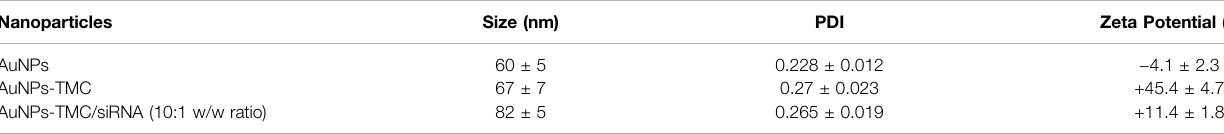
TABLE 2 | Size, PDI, and zeta potential of NPs.